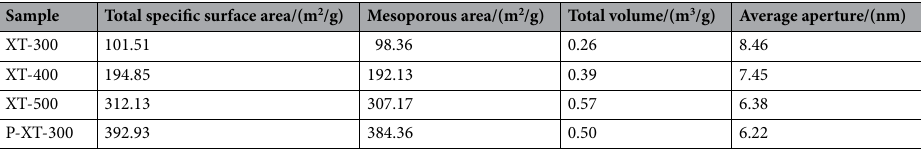
Table 4. BET analysis of phosphorus adsorption by adsorbents at different temperatures.